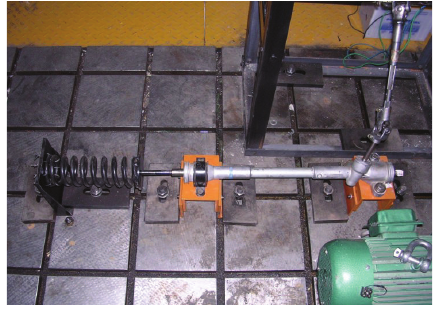
Figure 2: Rack and pinion steering gear in the test.